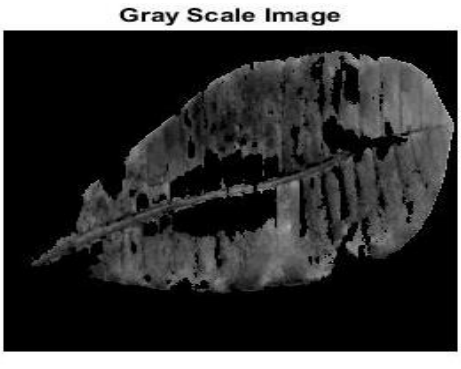
Figure 7. Gray scale image using cluster 2 and 45°co- occurrence angle